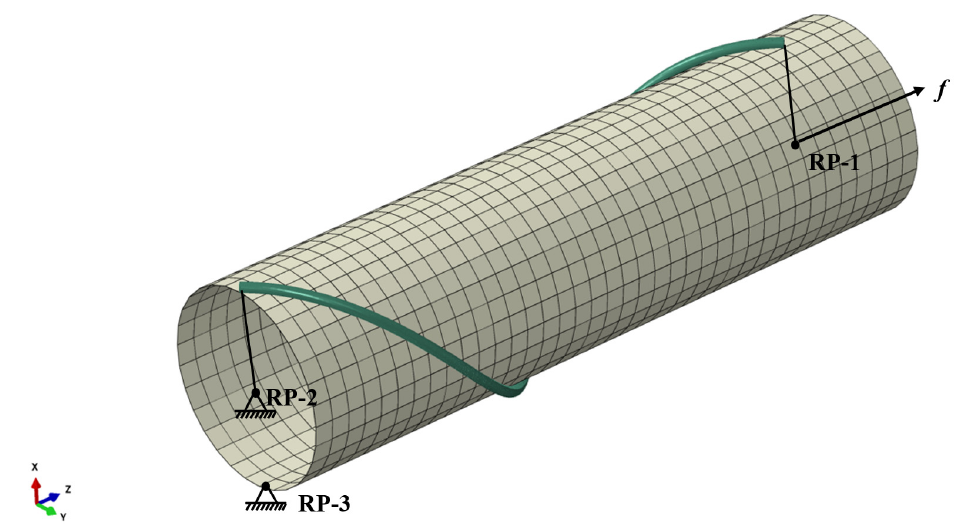
Figure 5. Finite element model and boundary conditions.